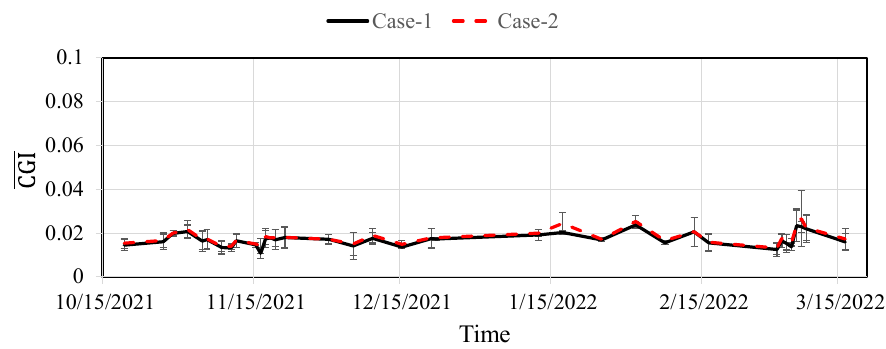
Figure 22. Monitored CGI and standard deviation.